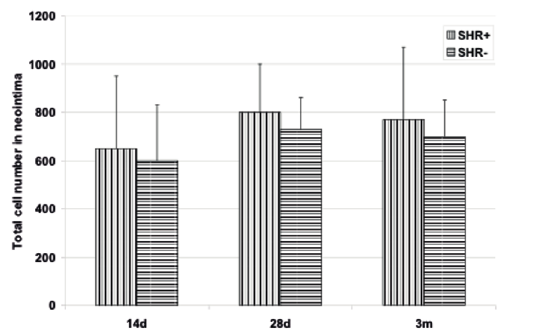
Figure 4. Bar graph demonstrating expression of dendritic cell markers in early neointima after balloon angioplasty in spontaneously hypertensive rats with (SHR+) and without ACE inhibitor